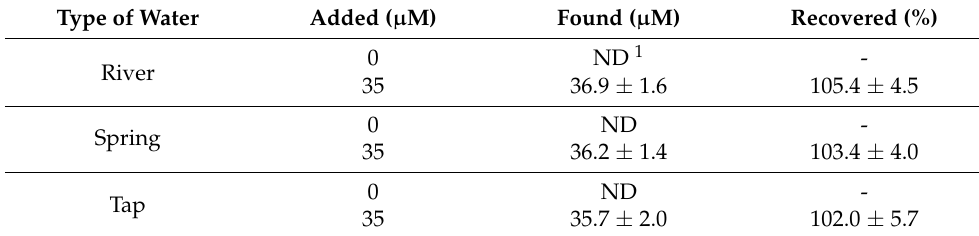
Table 1. Recovery tests for Fe 2+ spiked in real water samples.